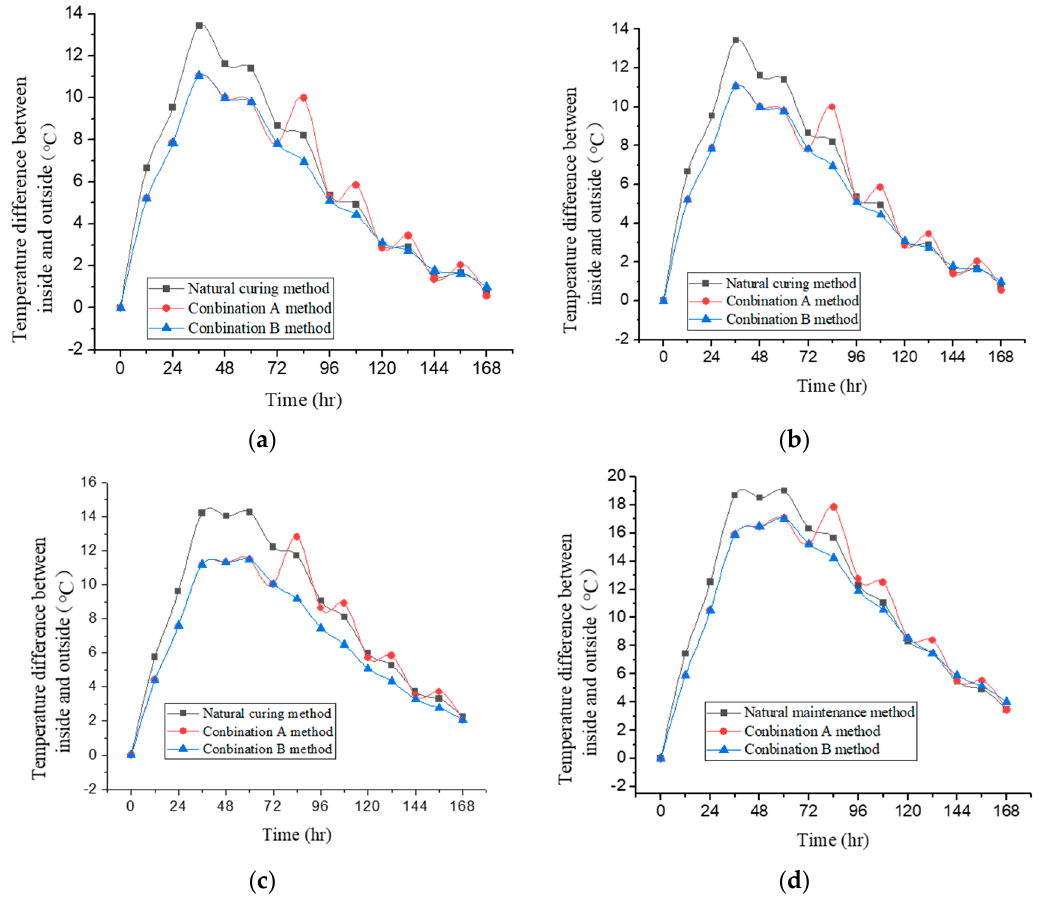
Figure 13. Comparison of the time-history curves of temperature differences of the key parts of the box girder. ( a ) Comparison of the time–history curves of the temperature difference between inside and outside of the web. ( b ) Comparison of time–history curves of the temperature difference between inside and outside of the bottom plate. ( c ) Comparison of time–history curves of the temperature difference between inside and outside of upper chamfers. ( d ) Comparison of time–history curves of the temperature difference between inside and outside of lower